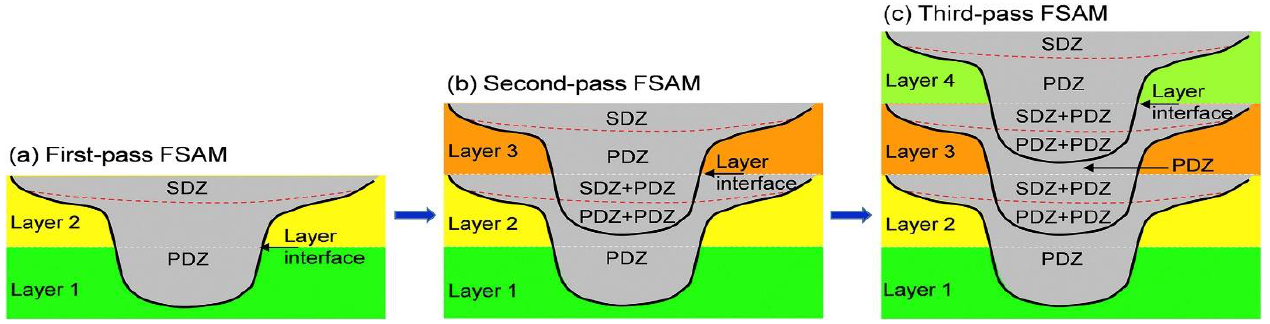
Figure 5. FSAM schematic illustration and final four-layered build obtained.